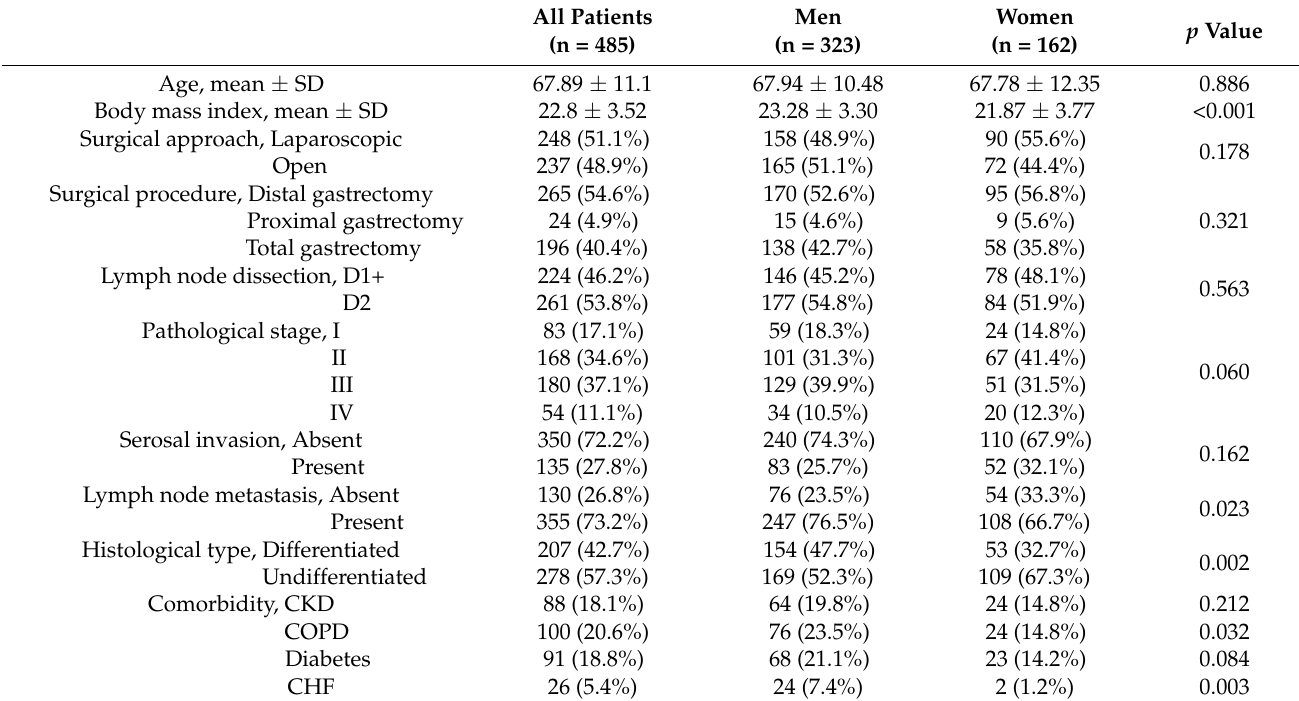
Table 1. Patient